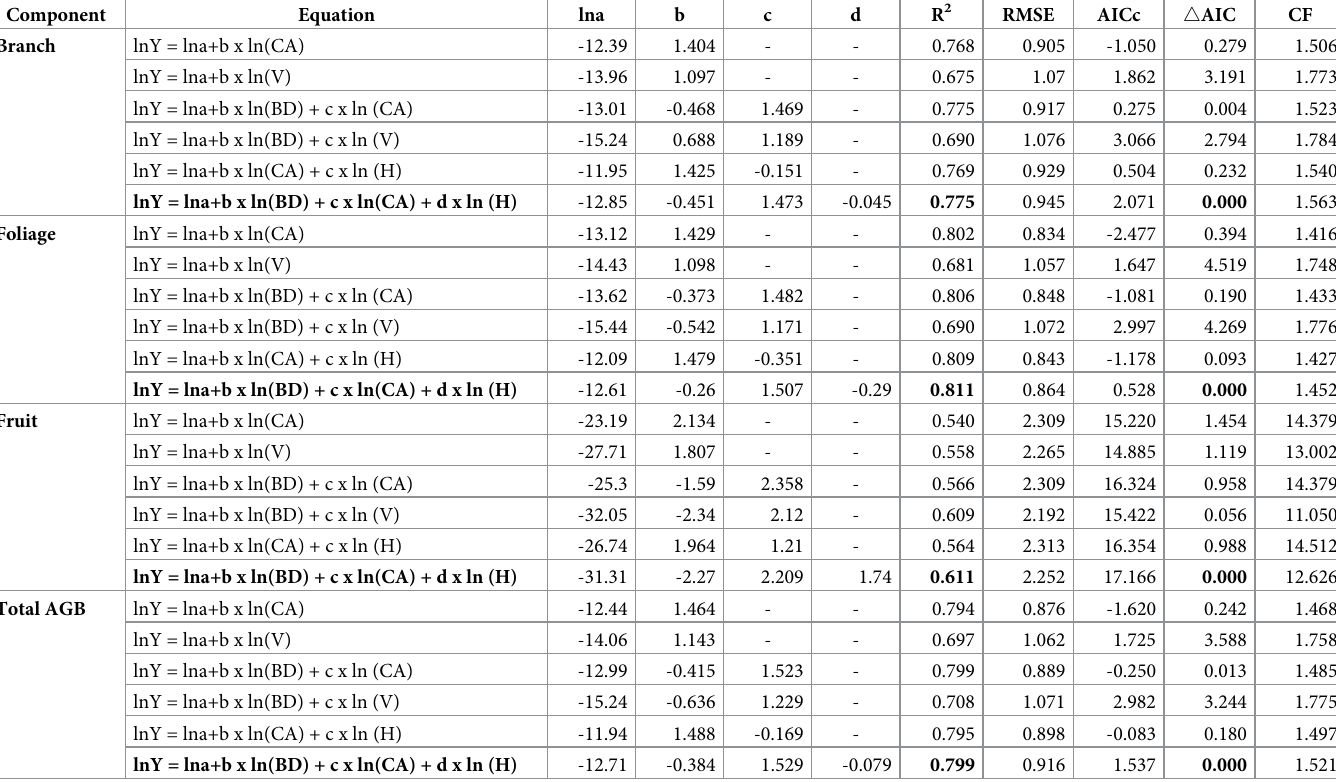
Table 3. Parameter estimates and model statistics of each model for branch, foliage, fruits, and total above-ground biomass of Nitraria sibirica Pall. Component Equation